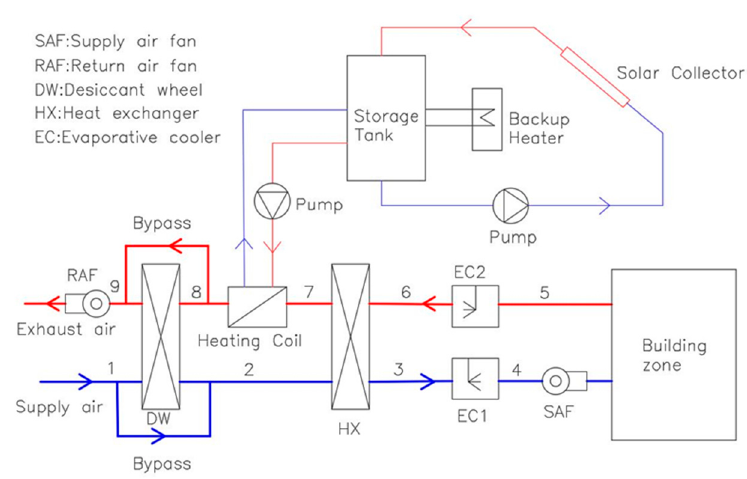
Figure 1. Schematic diagram of the basic solar desiccant evaporative cooling system [3].